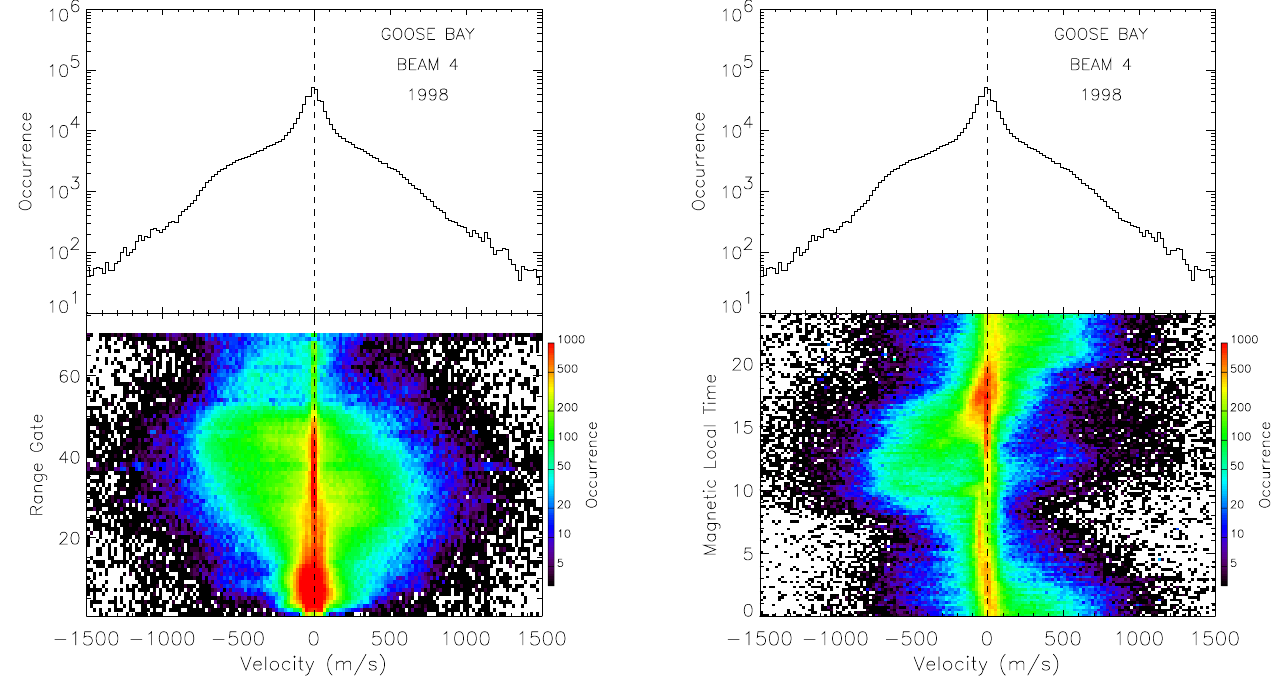
Fig. 4. Line-of-sight velocity distributions from Goose Bay beam 4 for the whole of 1998. Additionally shown are (a) the distribution in range gate-velocity space, and (b) the distribution in magnetic local time-velocity space. Positive line-of-sight velocities represent the flow toward the radar, whereas negative line-of-sight velocities represent the flow away from the